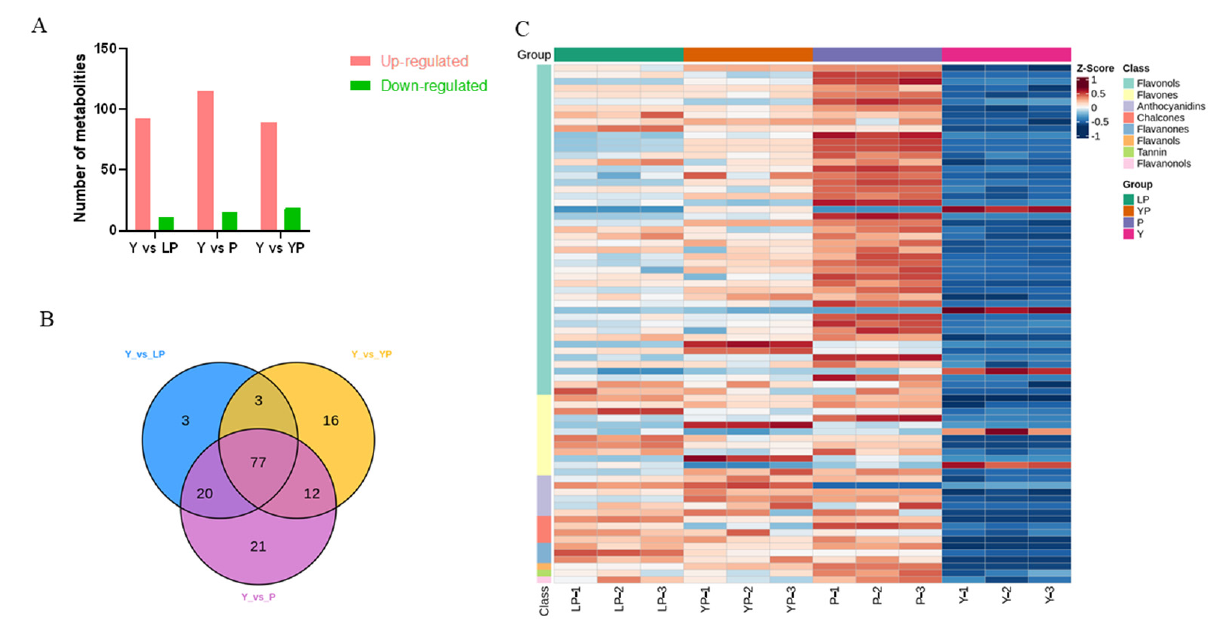
Figure 4. Analysis of differential metabolites. ( A ) The upregulated and downregulated differential metabolites in different petal groups. ( B ) Venn diagram of upregulated differential metabolites in different petal groups. ( C ) Heatmap of the differential metabolites. Red bars indicate highly accumulated metabolites, and blue indicates less accumulated metabolites.